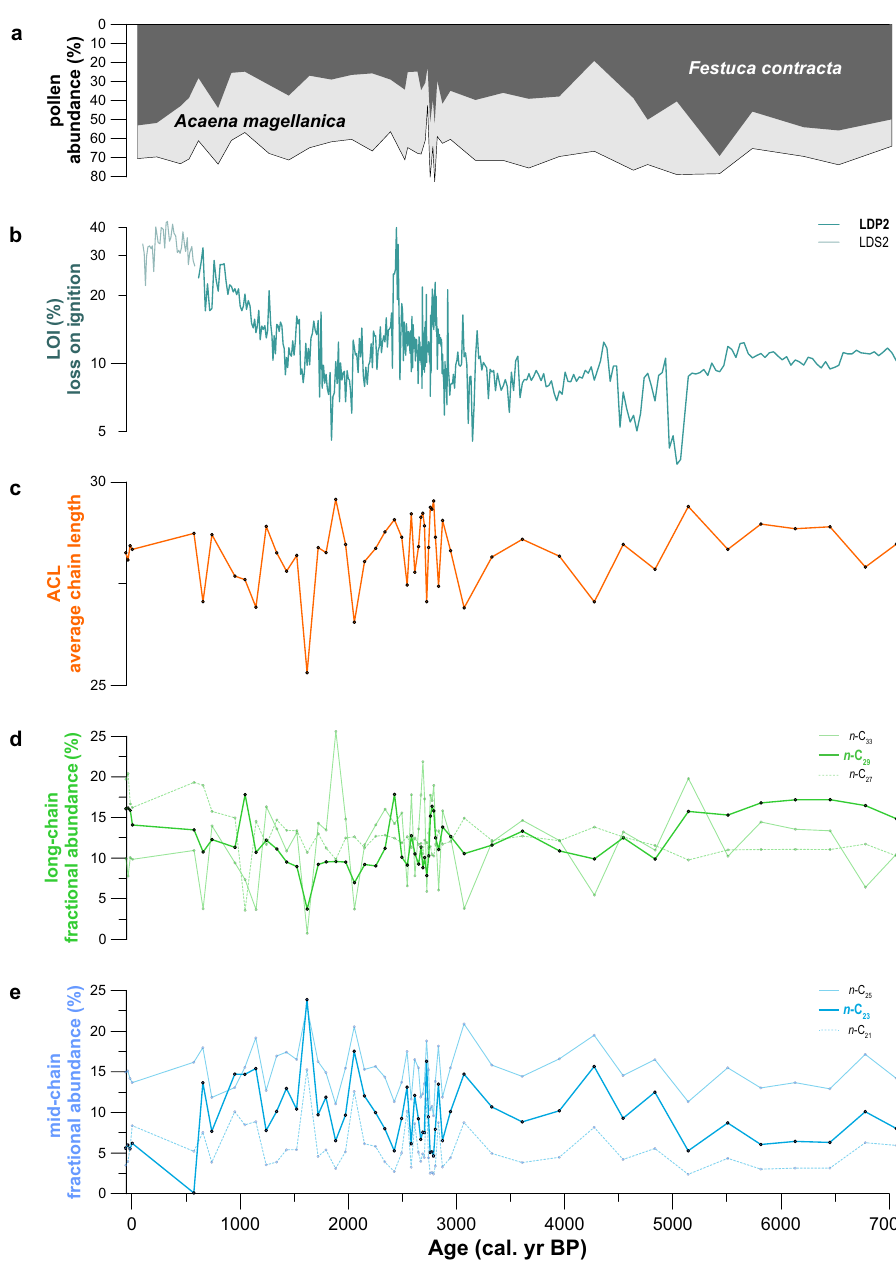
Fig. 3 Mid- to Late Holocene leaf wax distributions, pollen abundances, and organic content (LOI) in Lake Diamond. a Fractional abundances of mid- chain sedimentary n -alkanes, highlighting the predominantly aquatic C 23 homolog. b Similar, but for long-chain compounds, highlighting terrestrially- sourced C 29 . c The average chain length (ACL) distribution of down-core sedimentary n -alkane samples. d Variations in organic content as re fl ected by LOI measurements in both LDP2 and LDS2 cores. e A cumulative pollen diagram for core LDP2 after 60 , highlighting the abundance of two taxa that have dominated local vegetation throughout the studied period: Festuca and Acaena